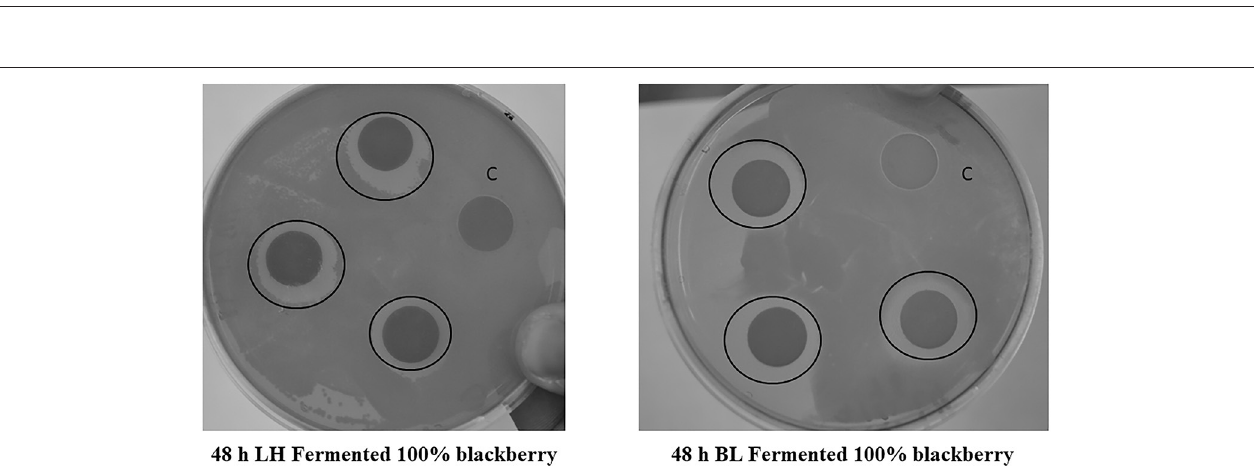
Frontiers in Sustainable Food Systems |